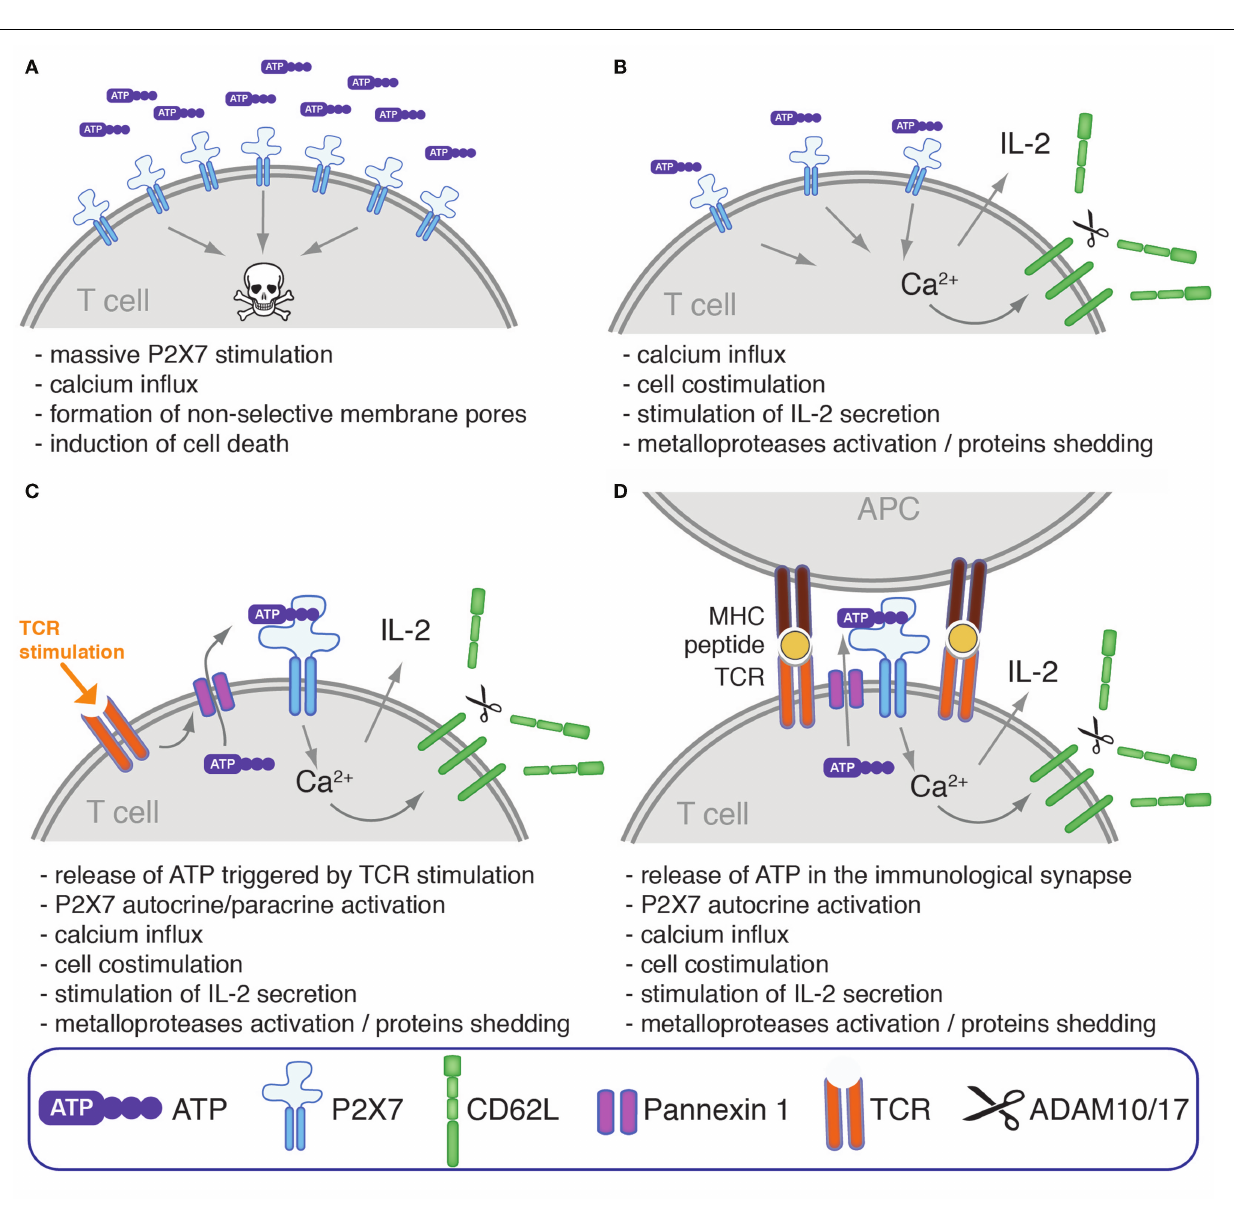
FIGURE 3 | Modulation of human T cells phenotype, response to mitogenic stimulation, and survival by ATP and P2X7 . P2X7-stimulation on the surface of human T cell may have different consequences which could hypothetically depend on the extracellular concentration of ATP, P2X7 density, expression of CD39 and other ATPases, on the nature of T cell subsets, and on their activation status. (A) High concentration of extracellular ATP have been reported to culminate, at least in vitro, in the induction of cell death possibly through the induction of massive membrane depolarization and permeabilization. (B) At lower ATP concentration and/or if cells express a low level of surface P2X7 and/or a high level of ATP-catabolizing enzymes, P2X7-activation could participate instead in T cell costimulation by enhancing the intracellular level of Ca 2 + , an universal second messenger (76, 78). This may result in the stimulation of NFAT, MAPKs, and IL-2 secretion (69, 70, 72), and in